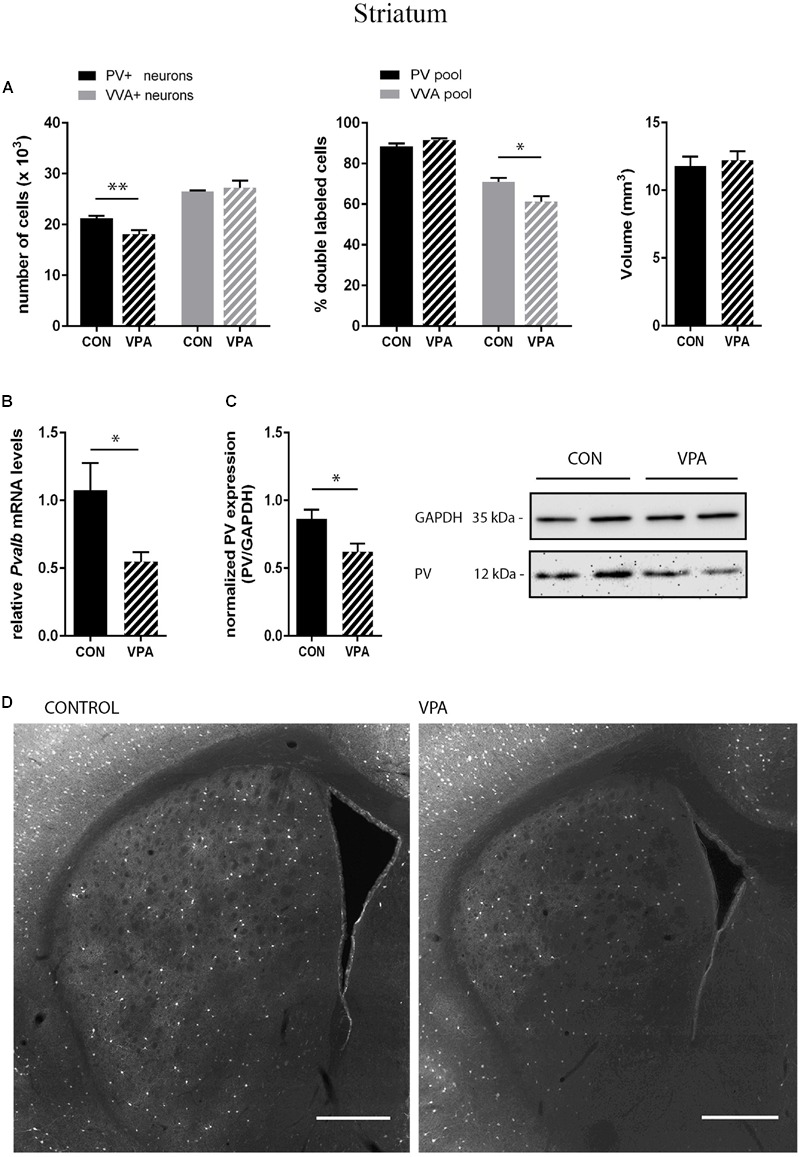
(A) Left: Stereological estimations of PV+ (black) and VVA+ (gray) cells in the striatum of PND25 in utero saline-(CON) or VPA-treated male mice (N = 5 each). Significant differences are observed in PV+ cells between CON and VPA mice (P-value < 0.01). Asterisks represent ∗P ≤ 0.05, ∗∗P ≤ 0.01, respectively. Middle: percentage of PV+ cells surrounded by VVA (black) and VVA+ cells showing PV expression (gray) in CON and VPA mice. Right: Volume of the ROI; i.e., the striatum. (B) qRT-PCR values from PND25 mice representing striatal mRNA levels were normalized to 18S mRNA levels and expressed as fold change compared to CON (N = 6 mice each). (C) Left: Quantitative Western blot analysis of striatal samples of PND25 CON and VPA mice (N = 6 each). Quantification of PV protein levels in the striatum is shown. GAPDH signals served as loading controls and were used for the normalization of the PV signals. Results are expressed as a percentage of normalized PV levels measured in a mixture of lysates from six WT striatums that was loaded on all membranes. Right: Representative Western blot signals. (D) Representative PV immunofluorescence images from the striatum of a CON and VPA mouse are shown. Scale bar: 200 μm. All data expressed as mean ± SEM.